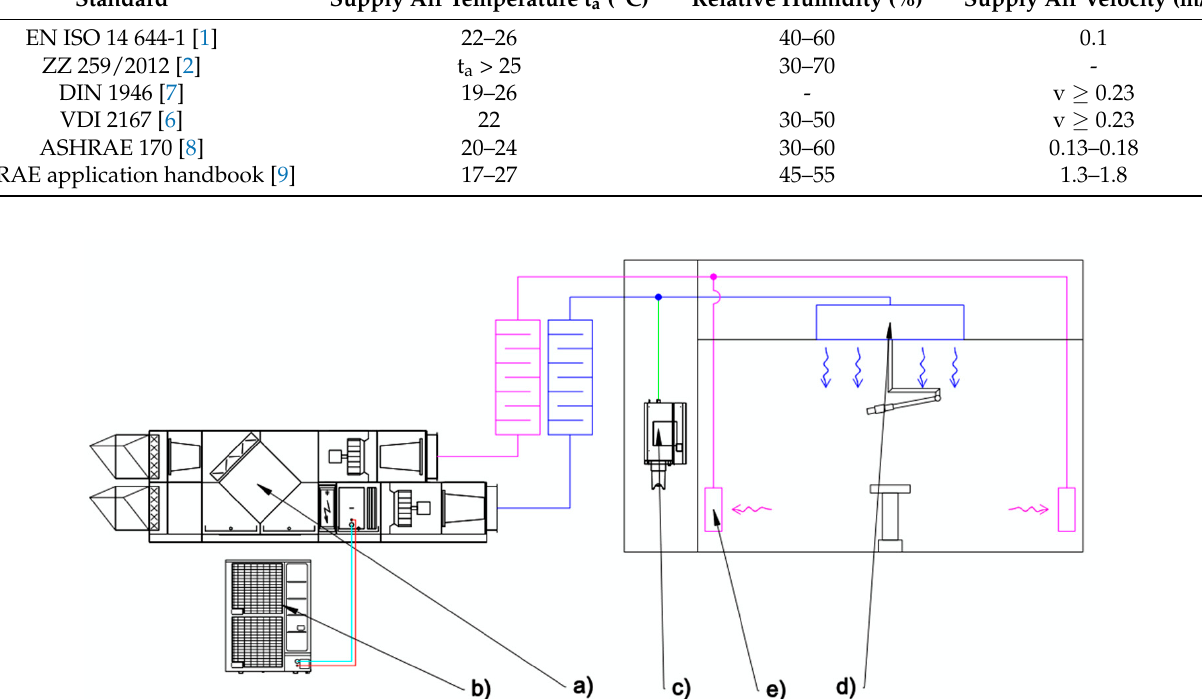
Figure 3. Scheme of HVAC equipment: (a) ventilation unit, (b) heat pump, (c) air humidifier, (d) LAFC, and (e) drainage outlets.